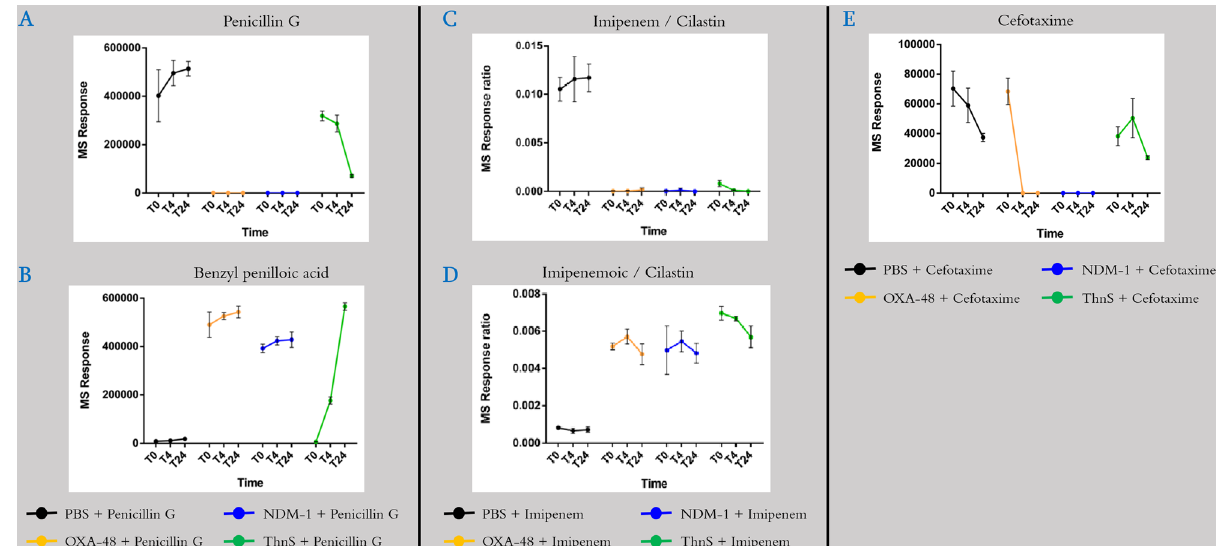
Figure 3. Monitoring the degradation of β-lactam drugs by the expressed ThnS enzyme compared to known bacterial β-lactamases (OXA-48 and NDM-1). ( A ) detection of Penicillin G over 24 h in presence or absence of the tested enzymes; ( B ) detection of the penicillin G metabolite (benzyl penilloic acid) when Penicillin G is incubated with the tested enzymes over 24 h; ( C ) monitoring the amount of imipenem when incubated with the tested enzymes over 24 h; ( D ) monitoring the amount of imipenem metabolite (imipenemoic acid) when imipenem is incubated with the tested enzymes over 24 h; ( E ) monitoring the amount of cefotaxime when incubated with the tested enzymes over 24